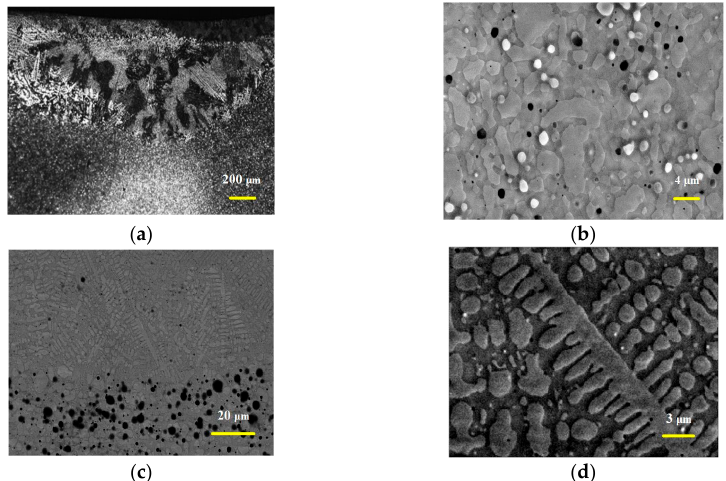
Figure 5. The surface microstructure of the Mo-Si-B alloy with laser remelting. ( a ) specimen surface morphology; ( b )substrate area; ( c ) melt pool and substrate transition area (BSE); ( d ) melt pool area.